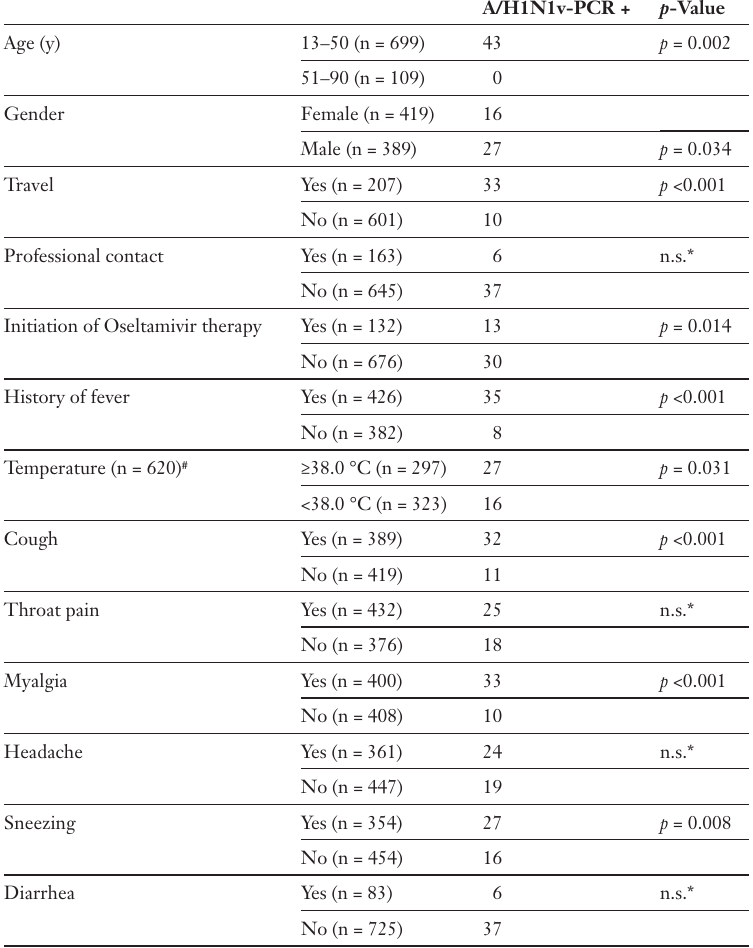
Risk factors for positive A/H1N1v-PCR.